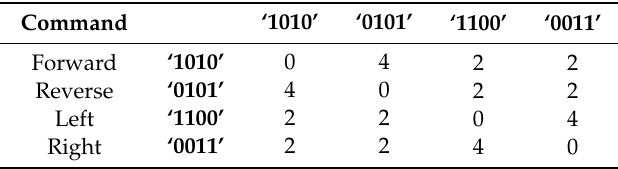
Table 2. Hamming distances between robot